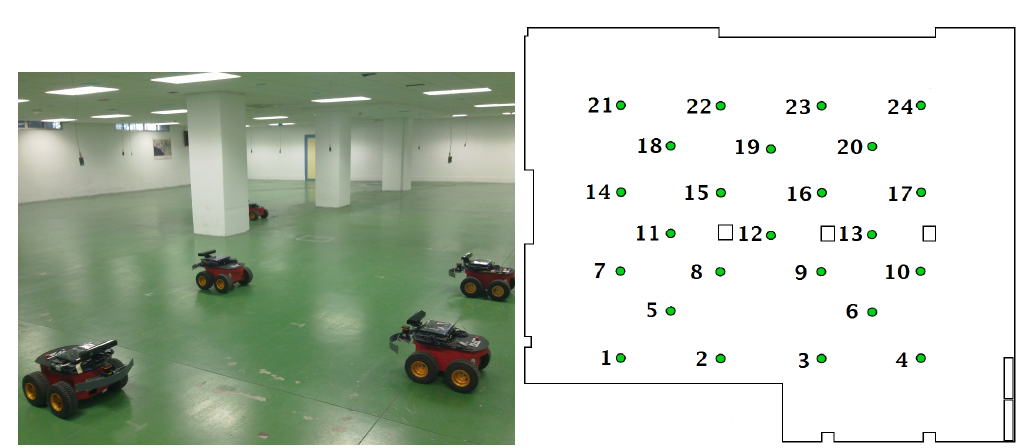
( Left ) Picture of the CONET testbed; ( Right ) Scheme of a typical WSN deployment in the testbed